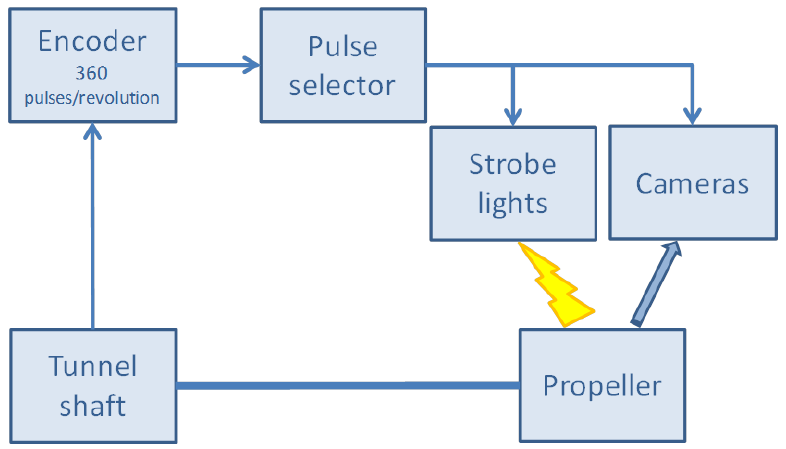
Figure 13. Cavitation tunnel set-up